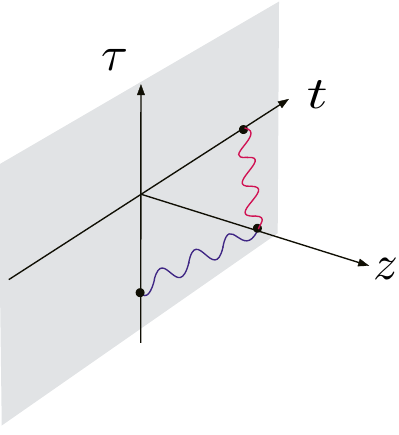
Figure 1 . We prepare a state by turning on sources in Euclidean time (cid:28) . This gives us some initial data on the (cid:28) = t = 0 surface in the bulk, which we can obtain from the bulk to boundary propagator (blue) and it’s time derivative. Then, we can further evolve this data in real-time t using the Lorentzian propagator (red) to obtain the real-time asymptotics, from which we read o(cid:11) the CFT one-point functions. Spatial directions in the CFT are